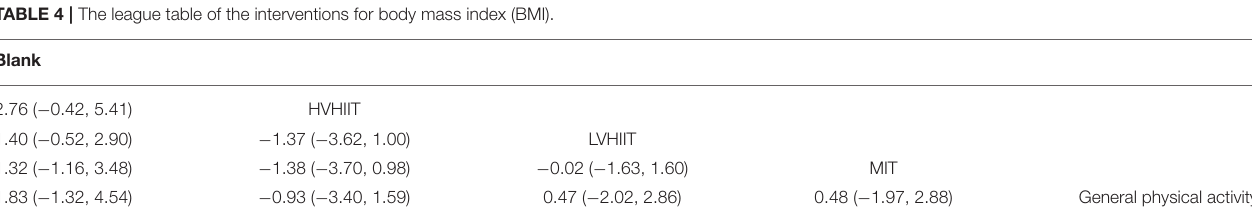
TABLE 4 | The league table of the interventions for body mass index